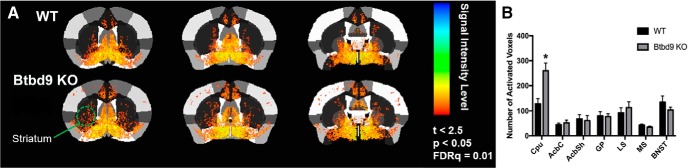
A, Coronal views of the averaged signal intensity from Btbd9 KO and WT controls. B, Btbd9 KO had significant increased neural activity in caudate and putamen and in the cerebral cortex. No difference was observed in other brain regions under investigation. Bars represent means plus SEs. Cpu: caudate/putamen; AcbC: nucleus accumbens core; AcbSh: nucleus accumbens shell; GP: globus pallidus; LS: lateral septal nucleus; MS: medial septal nucleus; BNST: bed nucleus of the stria terminalis; *p < 0.05.